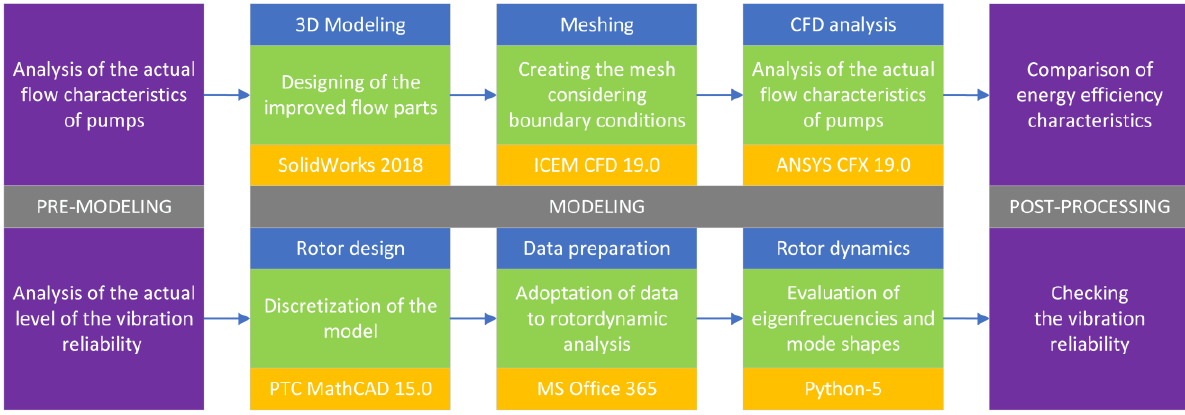
Figure 1. Flowchart of the research methodology.